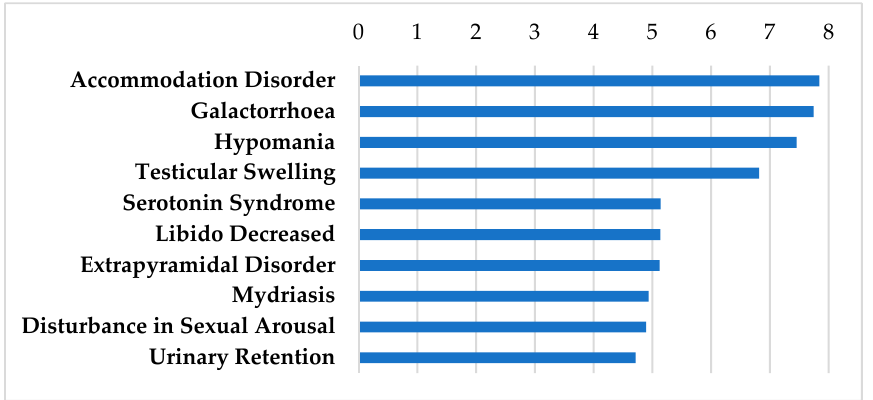
Figure 1. SIDER Side Effect Profile for the antidepressants. These drugs include amitriptyline, doxepin, fluoxetine, fluvoxamine, imipramine, milnacipran, and nefazodone. Frequencies of the top 10 side effects are shown based on the negative logarithm of their respective p values.